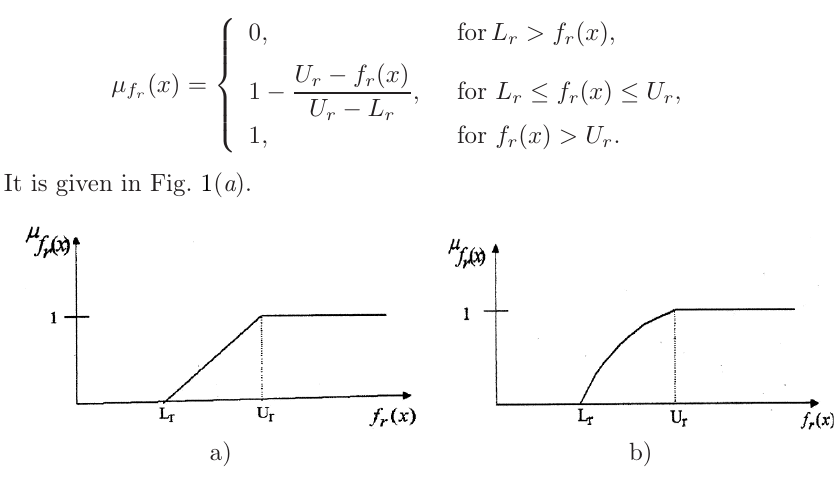
Figure 1. Different types of membership functions: a) linear, b)